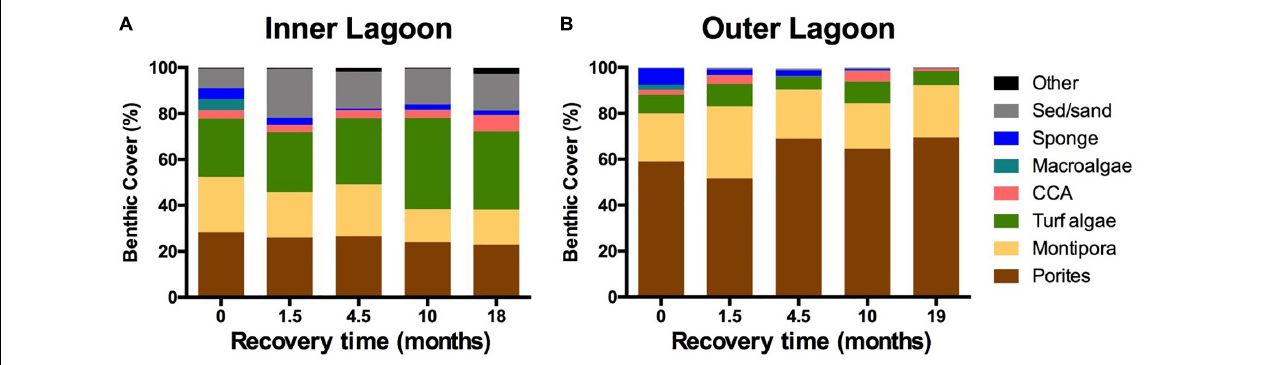
FIGURE 3 | Benthic community composition from the peak of the coral bleaching event (Oct. 2015) and after 1.5, 4.5, 10, and 18–19 months of recovery for (A) the Inner lagoon (PR4) and (B) the Outer lagoon (PR13) in K¯ane‘ohe Bay, O‘ahu. Data represent the means of four replicate transects.